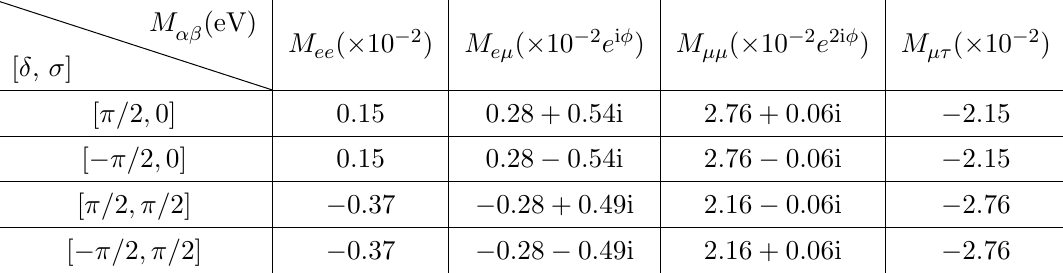
for various combinations of (cid:14) and (cid:27) in the NH case. (cid:11)(cid:12)